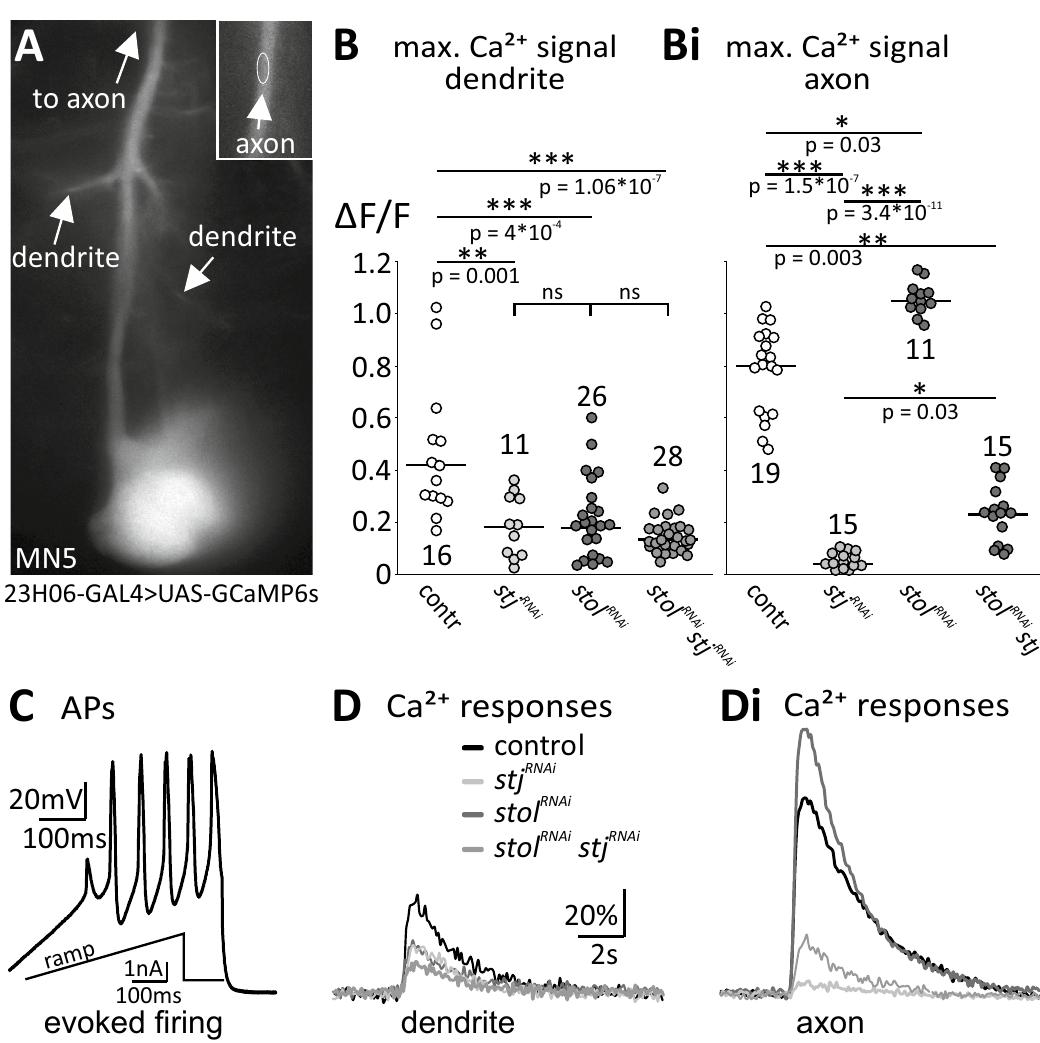
Figure 4. Activity-dependent calcium signals in dendrites are reduced by stol RNAi and stj RNAi , whereas axonal ones are reduced by stj RNAi but increases by stol RNAi . ( A ) Pupal MN5 with targeted expression of GCaMP6s. Regions of interest in dendrites and in the axon (inset, upper right corner) are indicated by arrows and white circles. (B–Di) Changes in GCaMP6s fluorescence (ΔF/F) in dendrites (B, D) and in the axon (Bi, Di) upon induced firing by somatic ramp current injection as shown in (C) . (B) As compared to control (white circles, n = 16) dendritic Ca 2+ signals are significantly reduced by stj RNAi (light gray circles; ** p = 0.001, n = 11) , stol RNAi (dark gray circles; *** p < 0.001, n = 26), and stj RNAi stol RNAi (medium gray circles; *** p < 0.001, n = 28), with no significant differences between both single- and the double knock-down. (Bi) By contrast, axonal Ca 2+ signals are significantly reduced by stj RNAi (light gray circles; *** p < 0.001, n = 15) but significantly increased following stol RNAi (** p = 0.001, N = 11) as compared to control ( Bi , N = 19). stj RNAi stol RNAi (medium gray circles, N = 15) also significantly reduces axonal Ca 2+ signals, but significantly less than single stj RNAi (* p = 0.03). Data in ( B and Bi) are presented as single data points and median. Statistical significance was tested by Kruskal–Wallis ANOVA with Dunn’s post-hoc test. ( D–Di ) Representative traces of (ΔF/F) over time in dendrites (D) and in the axon (Di) for control (black), stj RNAi (light gray), stol RNAi (dark gray), and stj RNAi stol RNAi (medium